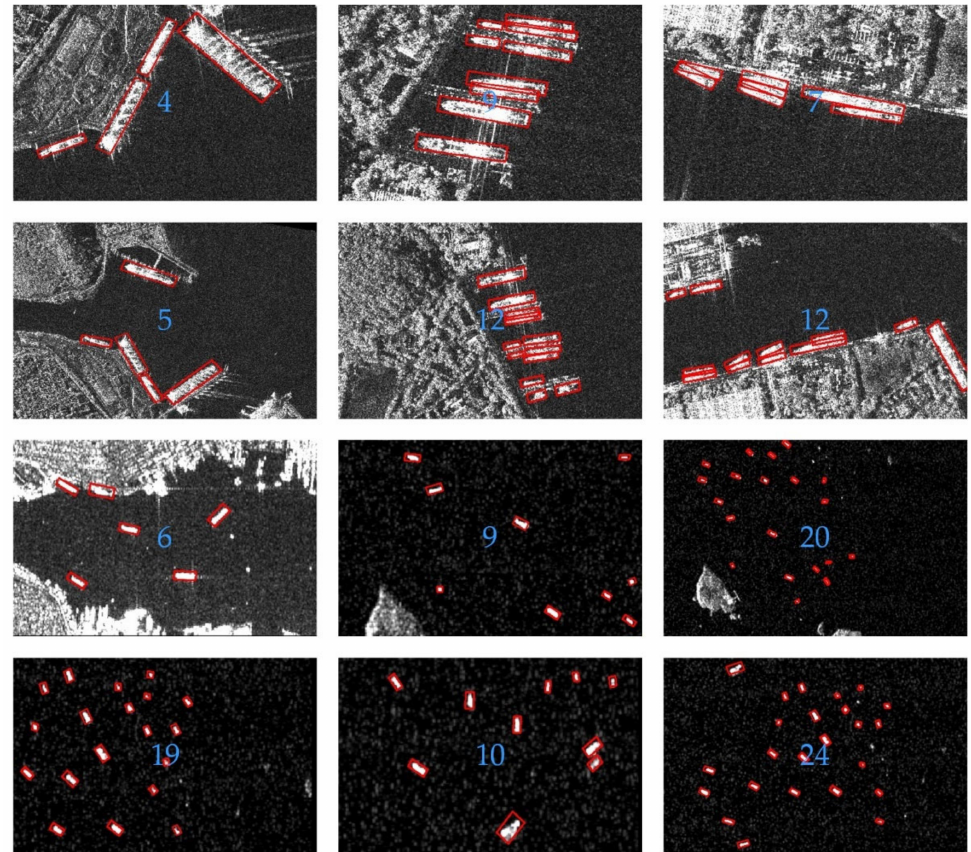
Figure 10. Experimental results on SSDD. The blue number represents the number of detected